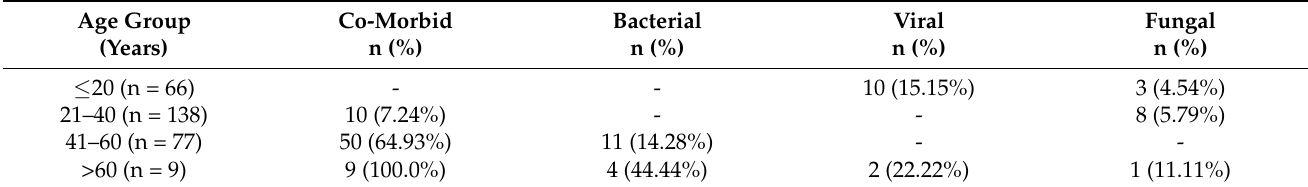
Table 6. Distribution of study subjects on the basis of opportunistic